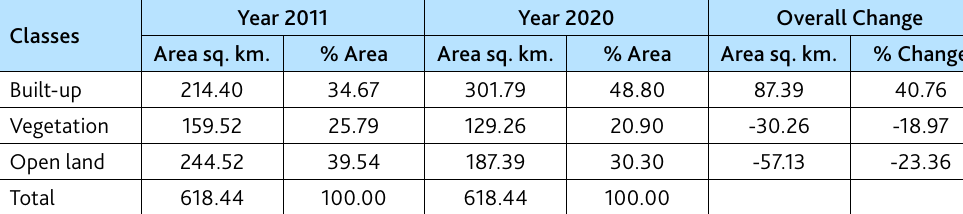
Table 6. Change detection Statistics for Ahmedabad data set